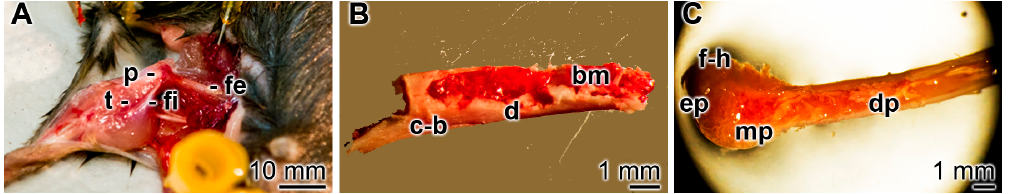
Figure 5. Dissection and collection of mice femurs. ( A ) Immediately after sacrificing, the animals and the femurs were dissected and collected. In addition to the exposed femur (fe), the tibia (t), patella (p), and fibula (fi) are visible; ( B ) the explant, measuring up to 25 mm in length and 2 mm in diameter, shows the compact bone zone (c-b) and the diaphysis (d), and exposes the bone marrow (bm); ( C ) after incubation in DMEM medium/FBS for up to 7 days, the specimens were collected and processed for bone marrow cell isolation. On the pictured specimen the femoral head (f-h), the epiphysis (ep), the metaphysis (mp), and the diaphysis (dp) can be distinguished.